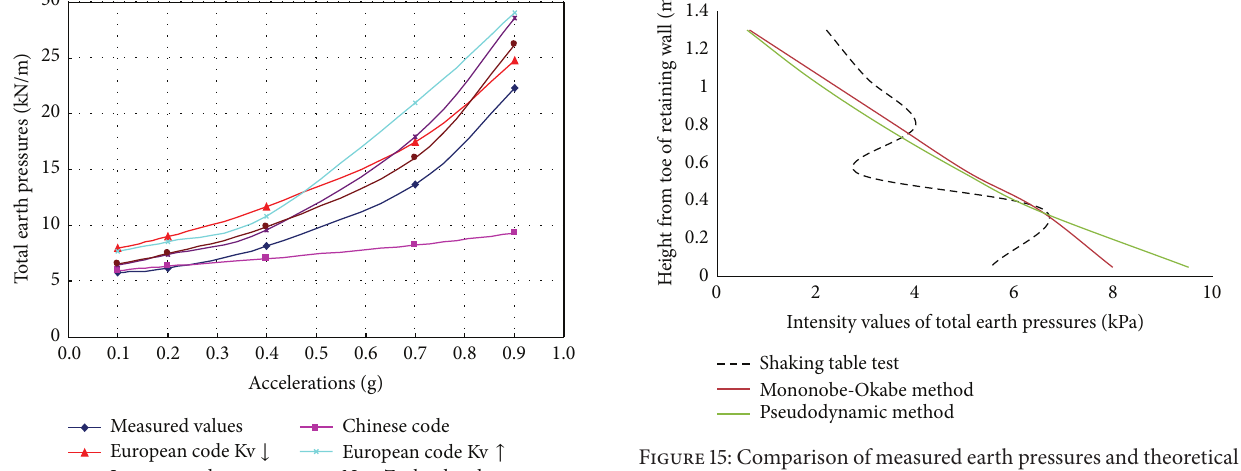
Figure 15: Comparison of measured earth pressures and theoretical results by pseudostatic method and pseudodynamic method for rock foundation (PGA of the input seismic wave is 0.4 g).